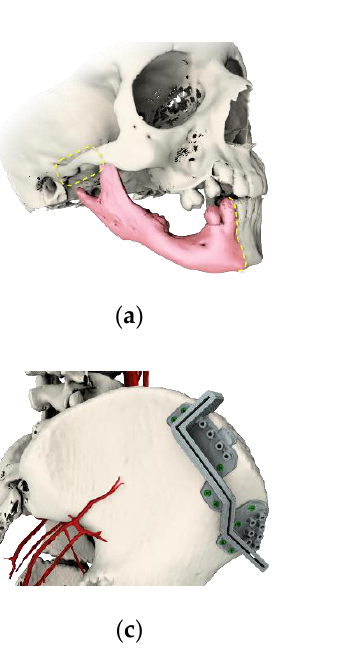
Figure 1. Virtual imaging and planning, with: ( a ) planning of the resection area; ( b ) surgical guideway for resection osteotomies; ( c ) surgical guideway for graft harvesting osteotomies; and ( d ) microvascularized graft supported with customized temporomandibular joint (TMJ) prosthesis consisting of polymeric glenoid fossa and titanium, and osteosynthesis trauma plate 2.0 (ChM, Bialystok, Poland).